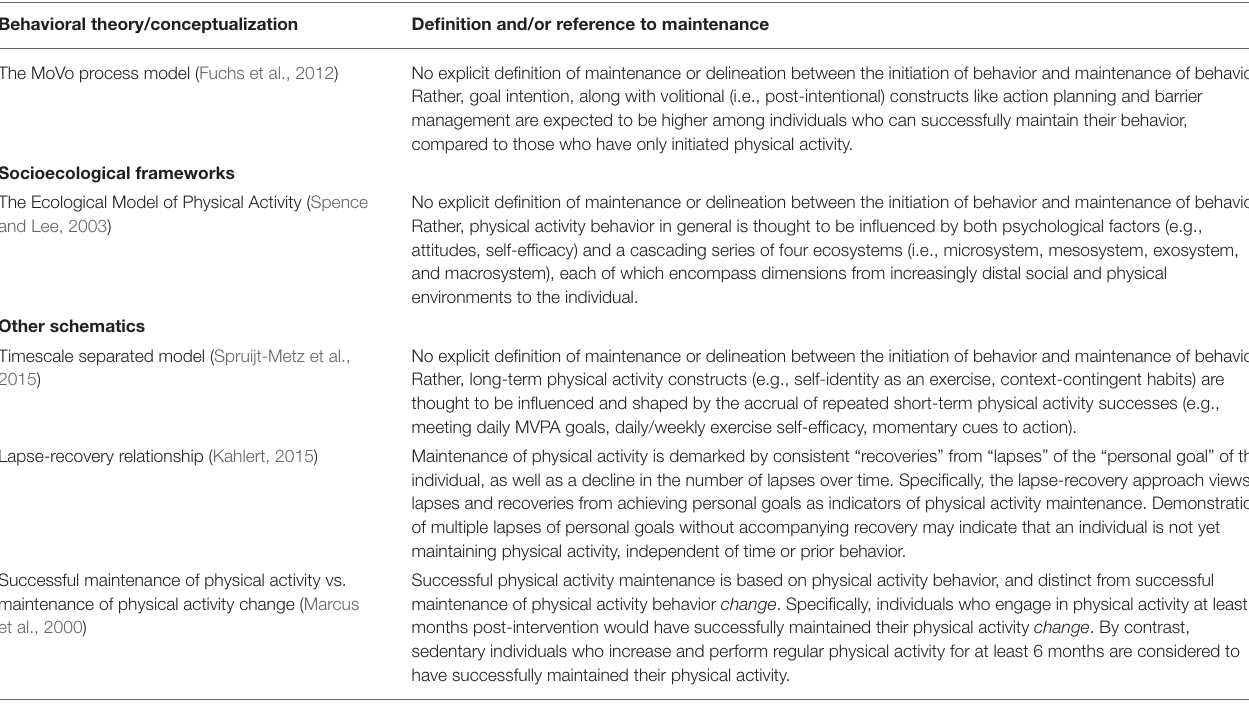
Table 1 details the results of our search of theories,